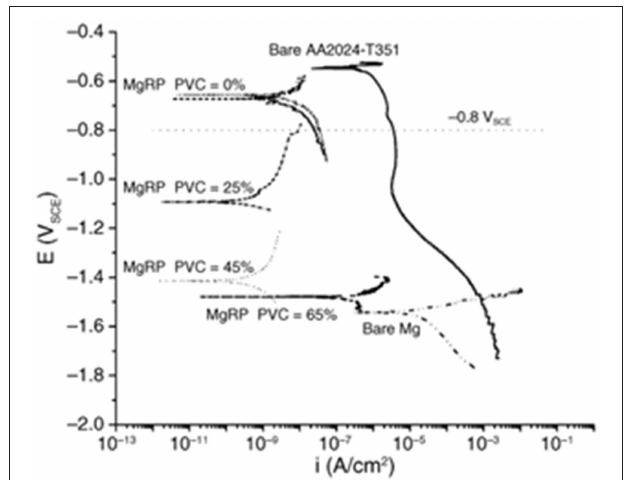
FIGURE 4 | The effect to Mg flake pigment concentration on the global galvanic potential of the MgRP/AA2024 system in 0.6 M NaCl ( King et al., 2014a ). Reproduced with permission.